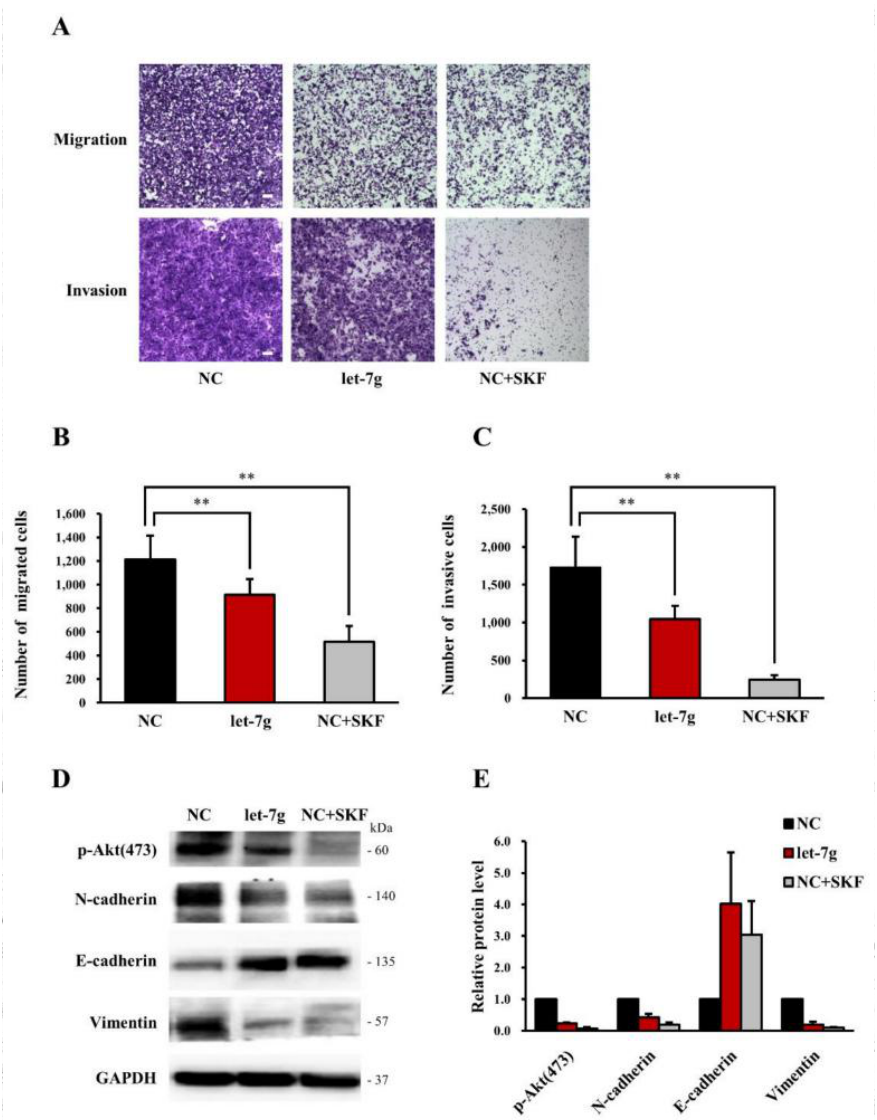
Figure 4. Effect of let-7g and a store-operated calcium (SOC) channel inhibitor on the motility of colorectal cancer cells. ( A ) DLD-1 cells transfected with a miRNA negative control and let-7g were subjected to transwell migration and invasion assays. Cells were incubated with or without 10 µ M SKF96365 for 48 h and then analyzed by imaging. Scale bar: 100 µ m. ( B , C ) DLD-1 cell migration and invasion were quantified by calculating the number of stained cells. ( D ) Epithelial-mesenchymal transition (EMT)-related protein levels in DLD-1 cells transfected with the miRNA negative control and let-7g plus treatment with or without 10 µ M SKF96365 were analyzed by Western blotting. The protein expression of glyceraldehyde 3-phosphate dehydrogenase (GAPDH) was assessed as an internal control. ( E ) Western blots of EMT-related protein expressions in DLD-1 cells were quantified. **, statistically significant at a p -value of